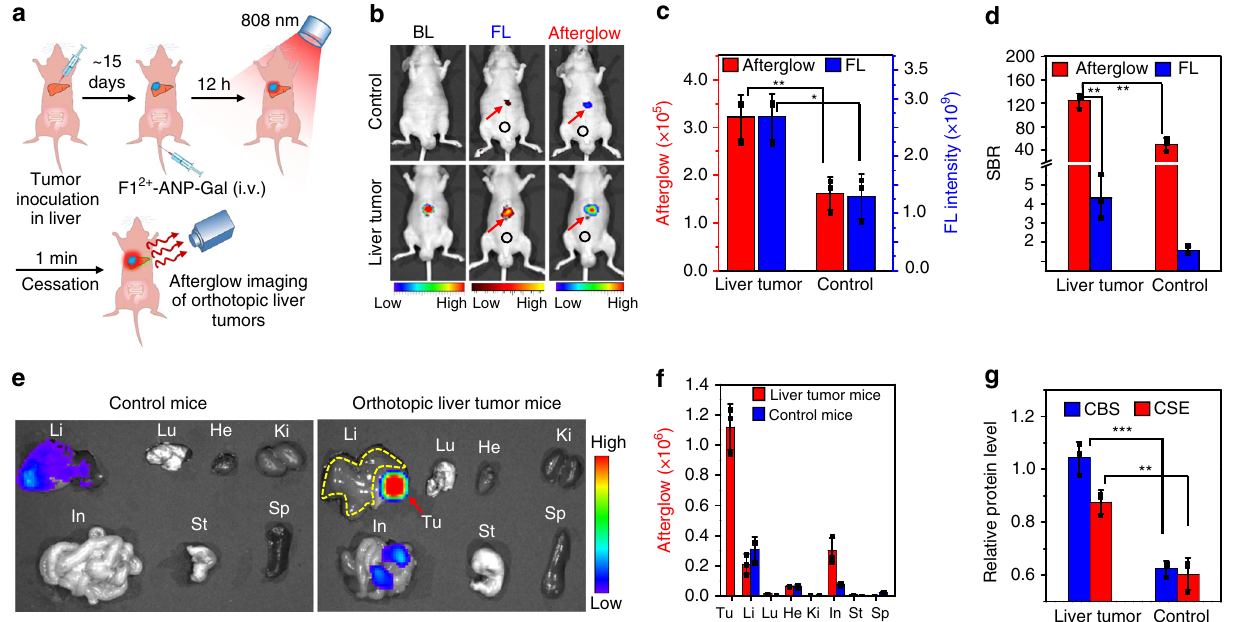
Fig. 5 Noninvasive imaging of orthotopic liver tumors in mice. a Schematic for afterglow imaging of orthotopic HepG2 tumors in living mice. b Bioluminescence (BL), fl uorescence (FL), and afterglow imaging of control mice (Control) and orthotopic HepG2 tumor (liver tumor) bearing mice at 12 h post i.v. injection of F1 2 + -ANP-Gal (211/100/8 μ g F1 2 + (BF 4 − ) 2 /MEH-PPV/NIR775, 200 μ L). c Afterglow (red) and FL (blue) intensities in the livers of control mice and orthotopic liver tumor-bearing mice. d Comparison of the SBRs for afterglow and fl uorescence imaging of livers in control mice and orthotopic liver tumor-bearing mice. Red arrows indicate the locations of livers, and black circles indicate the background locations. e Representative ex vivo afterglow images of main organs (e.g., liver (Li), lung (Lu), heart (He), kidneys (Ki), intestines (In), stomach (St), spleen (Sp), and tumor (Tu)) resected from control mice (left) and orthotopic HepG2 tumor-bearing mice (right) at 12 h post i.v. injection of F1 2 + -ANP-Gal. Red arrow and yellow dash box indicate the locations of HepG2 tumor in the liver and normal liver tissues chosen for region of interest (ROI), respectively. f Comparison of the average afterglow intensities of tumors and main organs resected from control (blue) and orthotopic liver tumor (red) mice. g WB analysis shows the relative CBS and CSE protein levels in the liver tissues resected from control mice and HepG2 tumor tissues resected from orthotopic liver tumor mice. All afterglow luminescence images were acquired for 60 s with an open fi lter, after pre-irradiation of mouse body or organs with the 808-nm laser (1 W cm − 2 , 1 min). All fl uorescence images were acquired with λ ex/em = 740/790 nm. Data denote mean ± s.d. (* P < 0.05, ** P < 0.01, n = 3). Statistical differences were analyzed by Student ’ s t test. Source data are provided as a Source Data fi